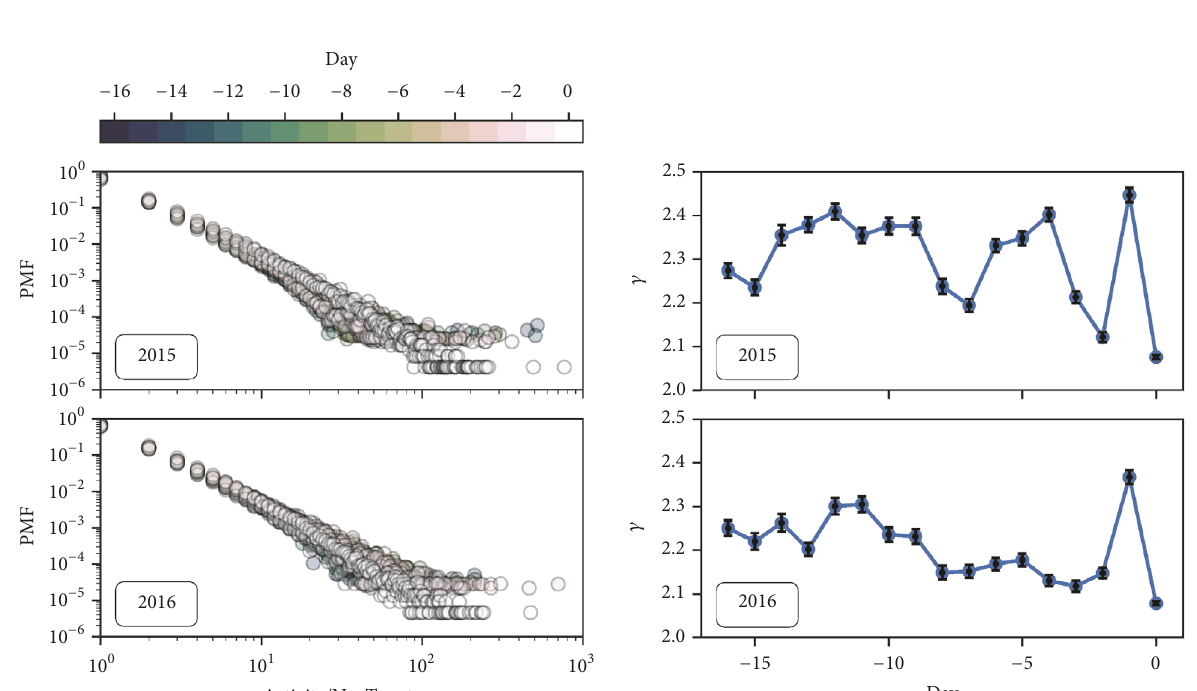
Figure 4: Temporalevolution of the distribution of activity per day in both electoralcampaigns (2015 in the top panels and 2016 in the bottom panels). Left panels: probability mass functions (PMF) of the distribution of activity for each day in color code. Right panels: daily evolution of the 𝛾 exponent of the power law fit of the activity distributions. The error bars correspond to 2𝜎